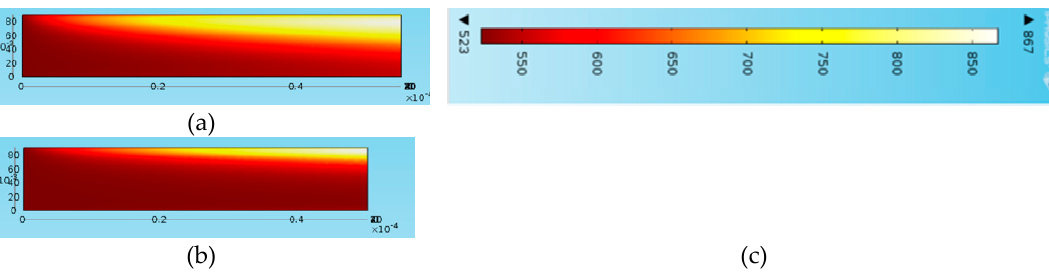
Figure 23. Temperature distribution at different solar concentrations: ( a ) solar concentration, C = 30 × , flow velocity, v = 0.0002 m/s, ( b ) C = 100 × , v = 0.002 m/s and ( c ) the colour scheme shows the temperature scale.